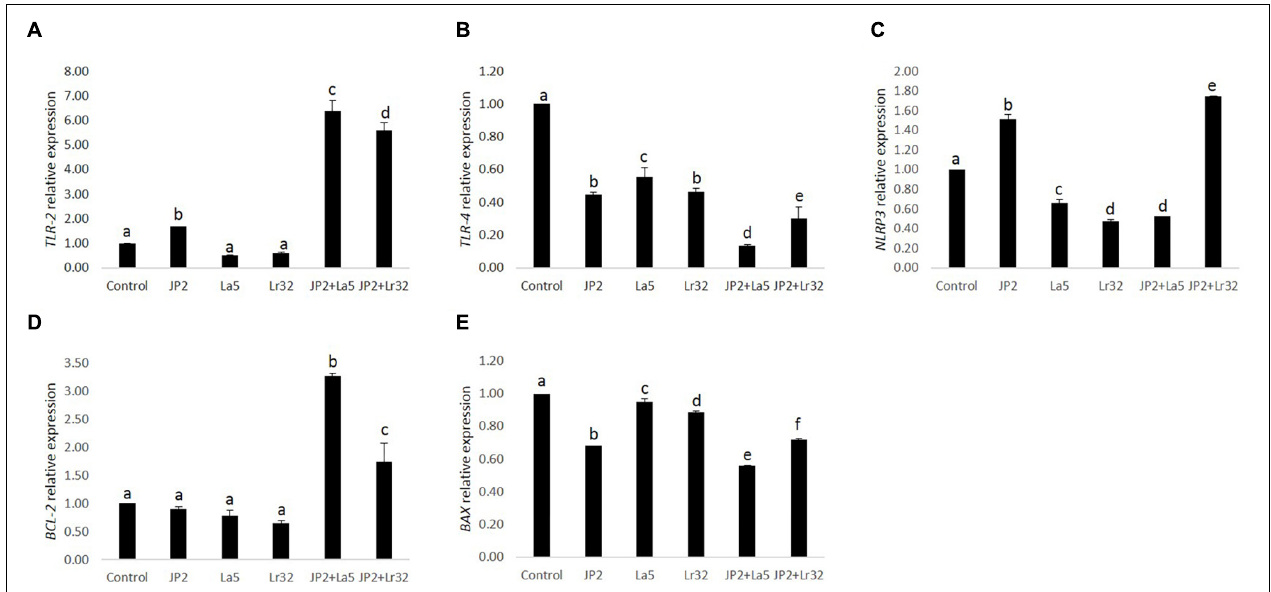
FIGURE 4 | Relative transcription of TLR-2 (A) , TLR-4 (B) , NLRP3 (C) , BCL-2 (D) , and BAX (E) in GECs mono-infected with A. actinomycetemcomitans (JP2) and/or L. acidophilus La5 (La5) or L. rhamnosus Lr32 (Lr32) for 24 h. Data on target genes were normalized to mRNA levels of the GAPDH reference gene (internal control). Control corresponds to non-infected GECs. ANOVA/Tukey, and different letters indicate statistical differences among groups ( p <